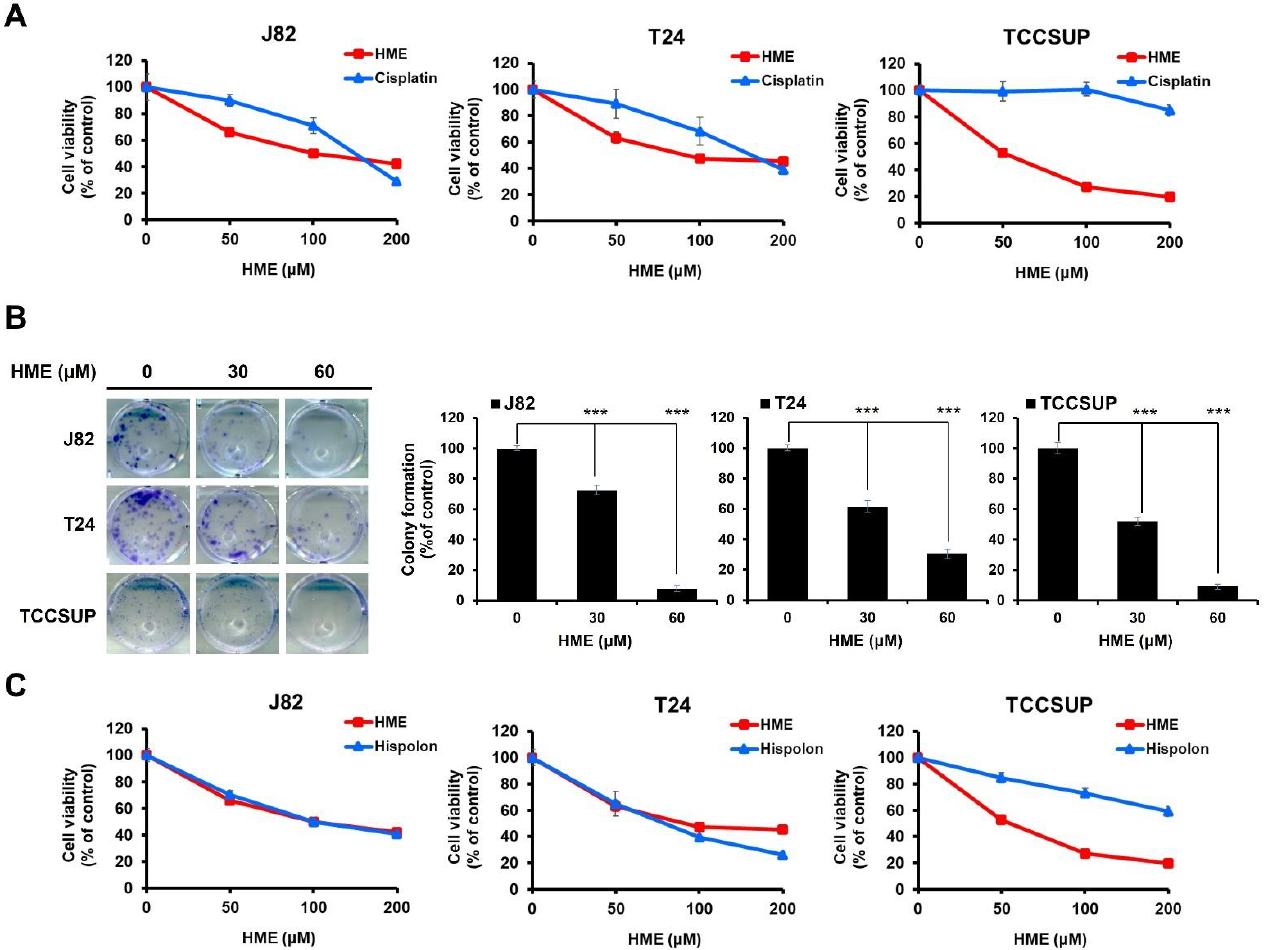
Figure 1. HME’s cytotoxic effect on human bladder TCC cell lines. ( A ) HME induces stronger cytotoxicity than cisplatin against human bladder TCC cells. Human bladder TCC cell lines J82, T24, and TCCSUP were treated with HME or cisplatin (0~200 μM) for 48 h, followed by cell viability determination using MTS assay. ( B ) HME impairs the colony-forming capacity of human bladder TCC cells. The levels of clonogenicity of HME-treated J82, T24, and TCCSUP cells were determined as described in Section 4. ***: p < 0.001. ( C ) Higher cytotoxic effect of HME than hispolon on TCCSUP cells while comparable cytotoxicity of these two drugs against J82 and T24 cells. J82, T24, and TCCSUP were treated with HME or hispolon (0~200 µ M) for 48 h, followed by cell viability determination using MTS